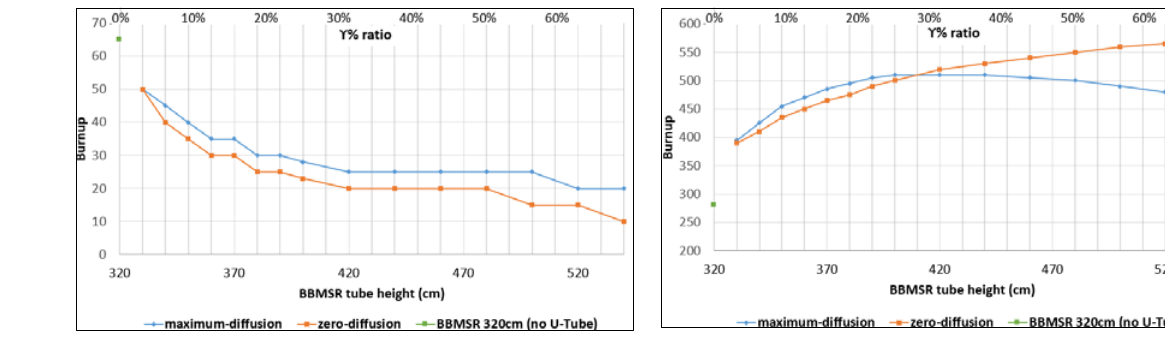
Figure 21. Minimum burnup versus ϒ% ratio Figure 22. Maximum burnup versus ϒ% ratio